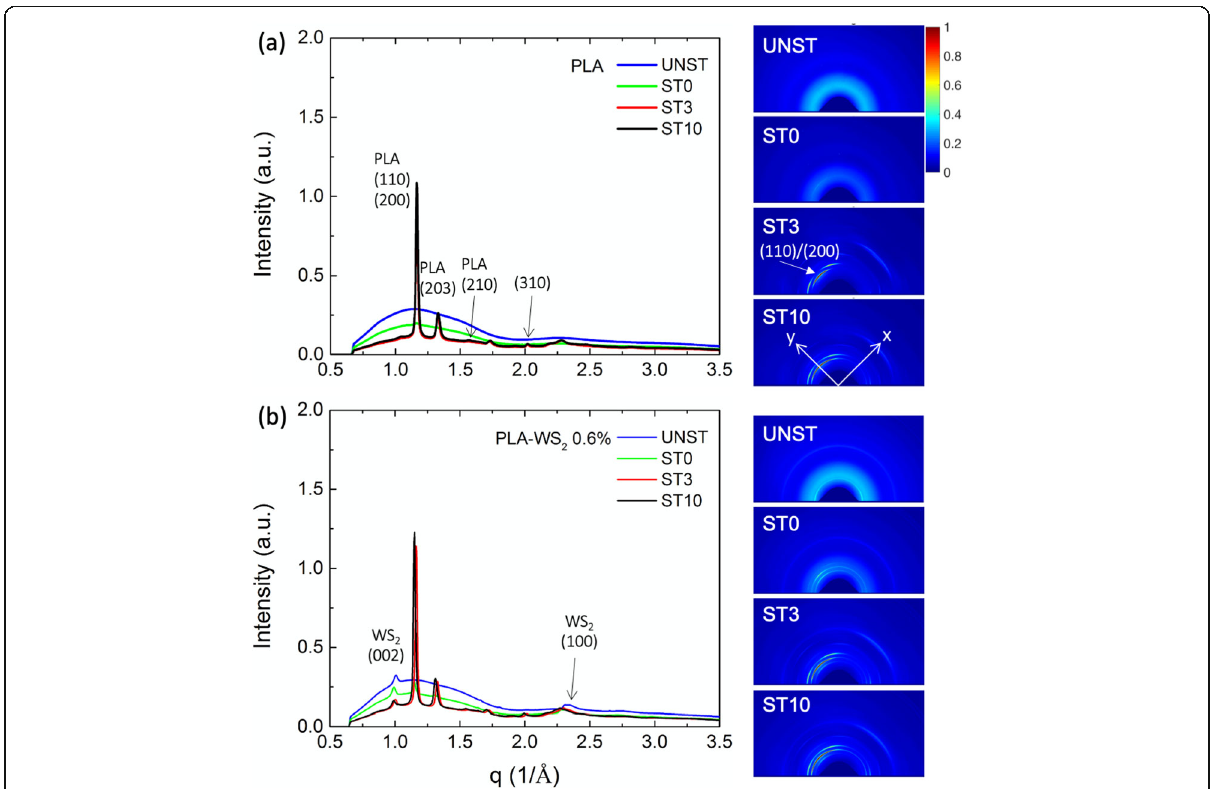
Fig. 4 WAXS 1D Intensity vs. scattering vector q (left) of PLA (a) and PLA-WS 2 0.6% (b) films obtained after integration of the corresponding 2D patterns (on the right) over the azimuth angle: UNST, ST0, ST3 and ST10 films (for each type of sample only the pattern that best reproduces the average behaviour among the different measurements was selected). The intensity scale of the 2D patterns is the same for all the samples. The stretching direction is along the x